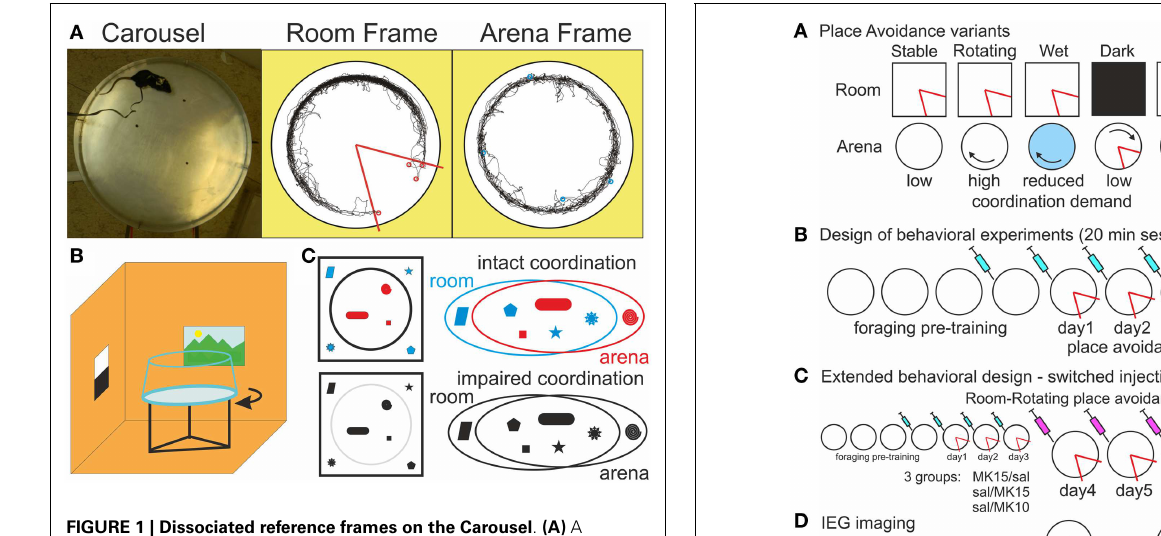
FIGURE 1 | Dissociated reference frames on the Carousel . (A) A photograph of the Carousel arena (left) and example trajectories in the stationary Room frame (middle), where the shock zone (red) is defined and in the rotating Arena frame (right) during a room-defined place avoidance session. Red and blue circles mark locations where shocks were administered in the Room and Arena frames, respectively. (B) Schematics of the rotating arena in a stationary room. Continuous rotation of the arena dissociates spatial reference frames of the stationary room and the rotating arena (C) Illustration of the cognitive coordination function in a color model, where cue color facilitates discrimination between two sets of cues.When color is lost, discrimination becomes more difficult.The two cue sets are still clearly delineated from the top view (left), but the distinction is much less clear from the perspective of the animal, let alone a multi-modal spatial representation system in the hippocampus (right).